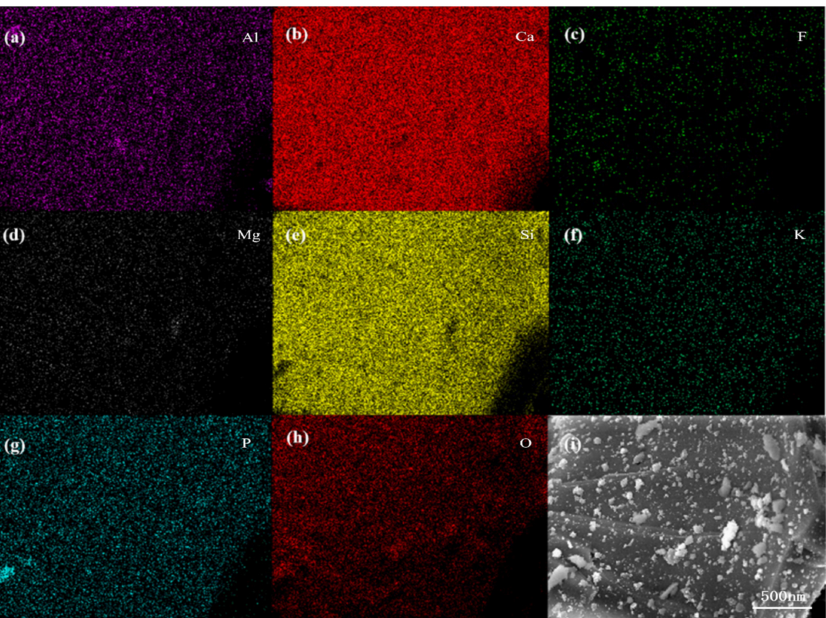
Figure 4. SEM-EDS elemental mappings of phosphorous slag: ( a ) Al; ( b ) Ca; ( c ) F; ( d ) Mg; ( e ) Si; ( f ) K; ( g ) P; ( h ) O; ( i ) scan position.